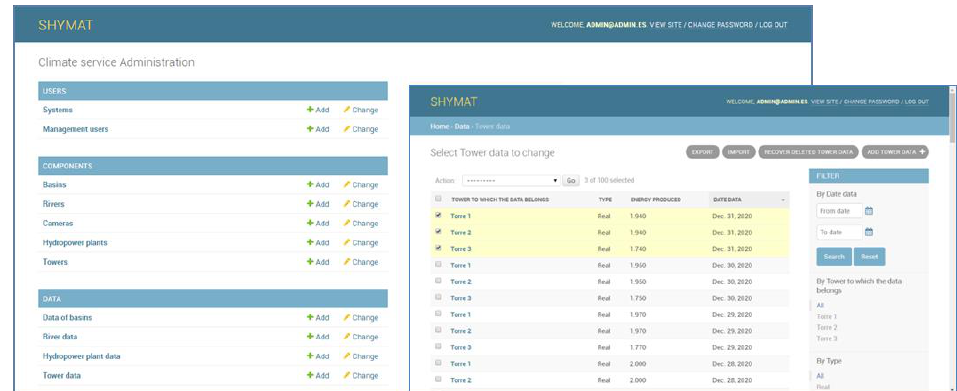
Figure 3. Example of visualization of the web administration panel of the SHYMAT service for the pilot RoR system. It shows the “users section”, where systems and different users can be managed; the “components section”, where basins, rivers, load chambers, hydropower plants, and power grid elements can be managed; and the “data section”, where data related the system components can be managed. Some examples of management options are also displayed, such as add/change data, export/import setting, and filter options.